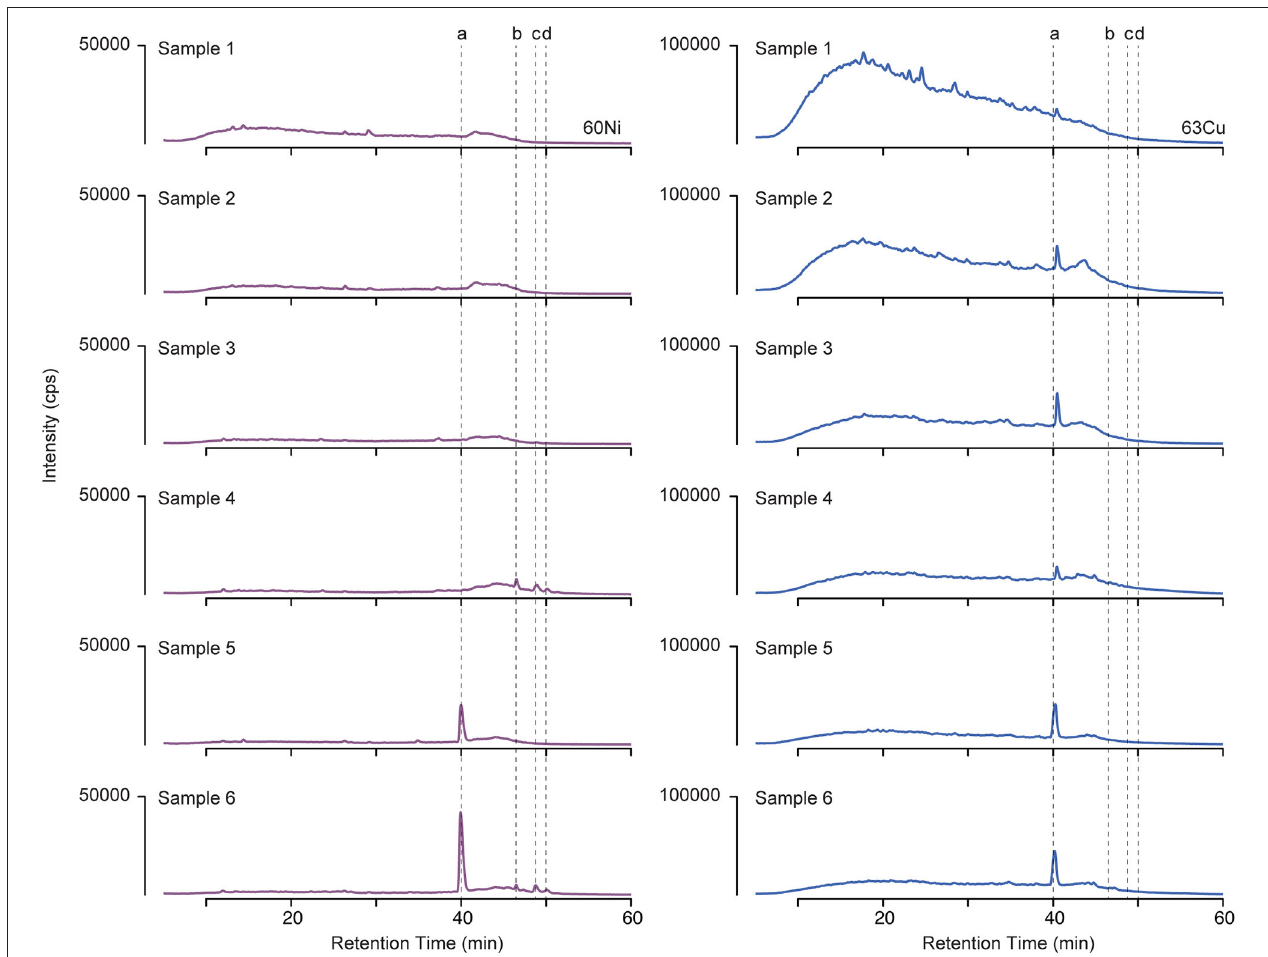
FIGURE 2 | 60 Ni (left) and 63 Cu (right) LC-ICPMS chromatograms from the six samples collected along the transect from the coast of Peru (sample 1) to an oligotrophic station near Tahiti (sample 6). Peak intensities have been scaled to account for differences in preconcentration. Dashed lines indicate retention times of compounds ( a–d ) discussed in the